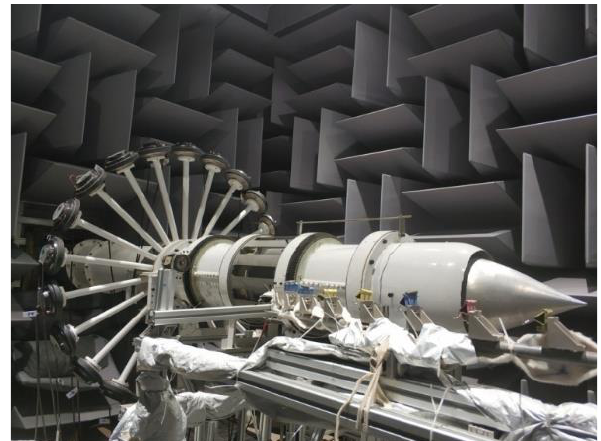
Figure 7. Experimental device of spinning mode generator and other sections assembly.